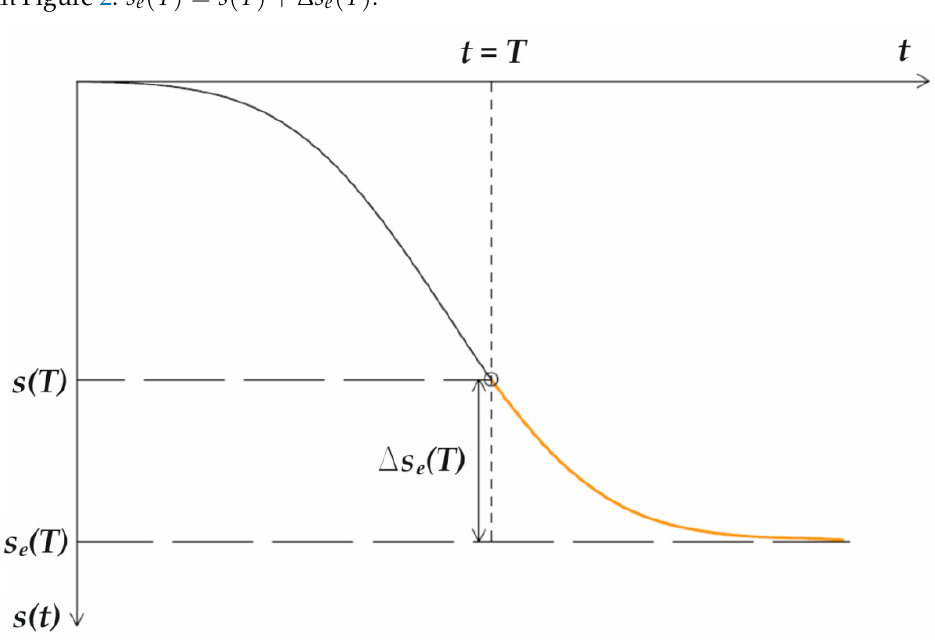
Figure 2. Subsidence after the end of exploitation in time T